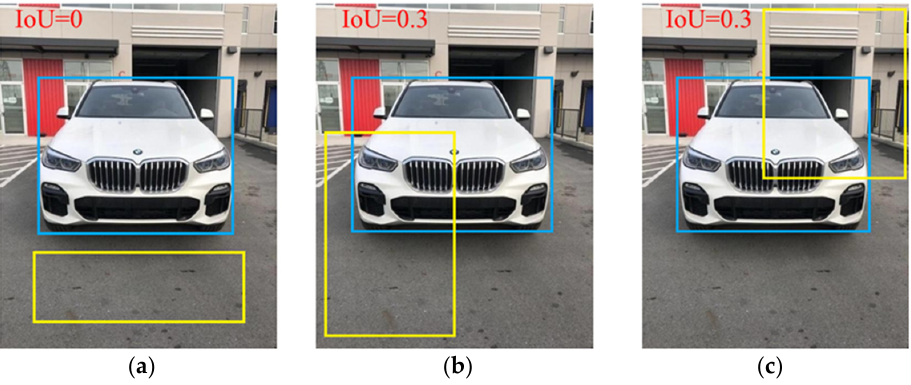
Figure 8. Network comparison before and after introducing the CBMA attention mechanism.